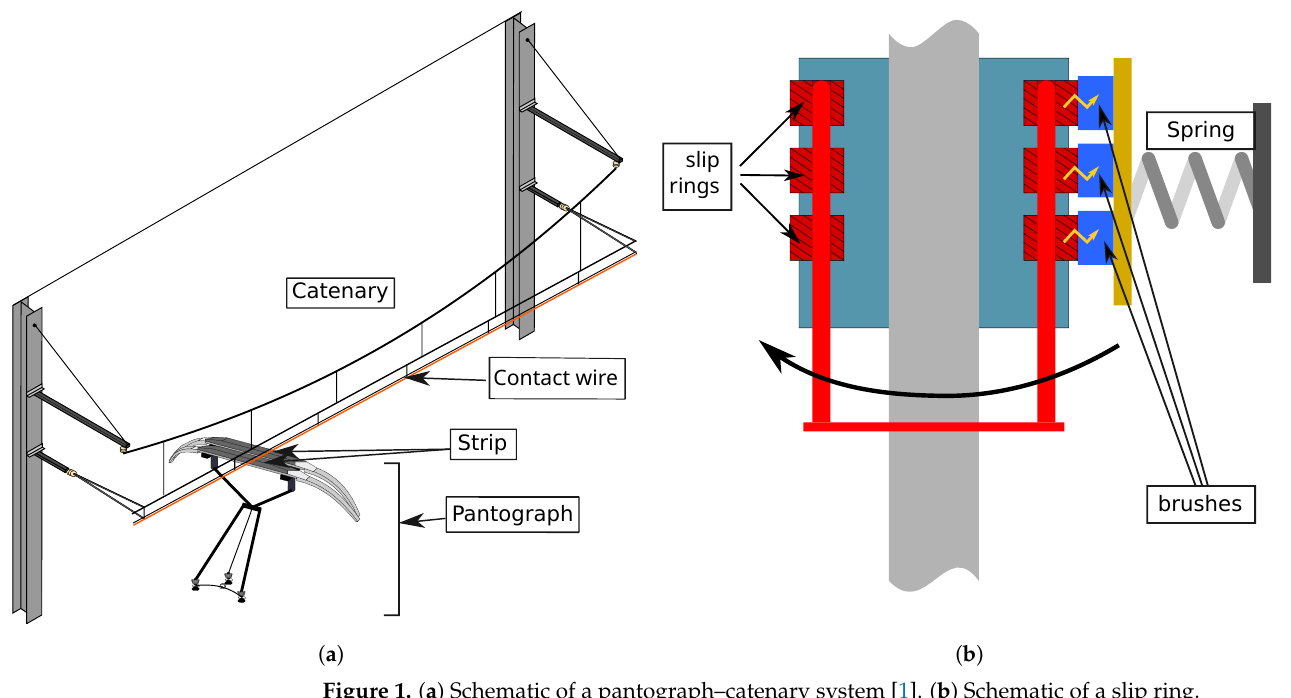
Figure 1. ( a ) Schematic of a pantograph–catenary system [1]. ( b ) Schematic of a slip ring.